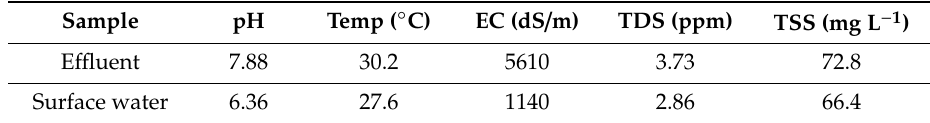
Table 1. Psychochemical characteristics of the e ffl uent and surface water samples showing the pH, temperature, electrical conductivity, total dissolved solids and total suspended solids. ES = electrical conductivity, TDS = total dissolved solids and TSS = total suspended